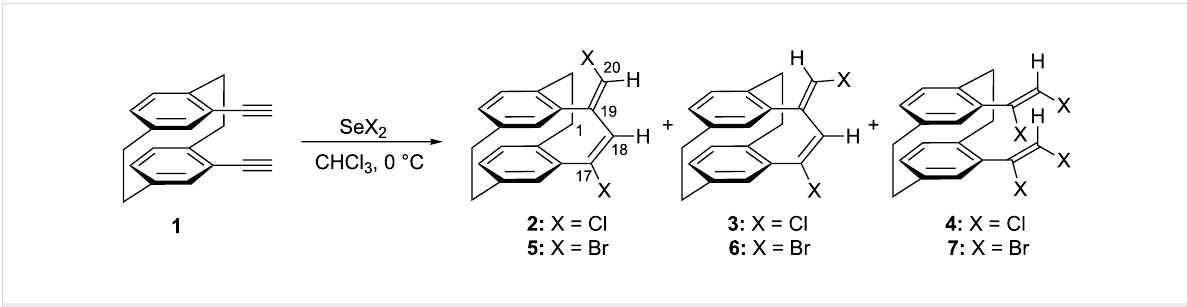
Scheme 1: Reactions of selenium dichloride and selenium dibromide with pseudo-geminal bis(acetylene) 1 .